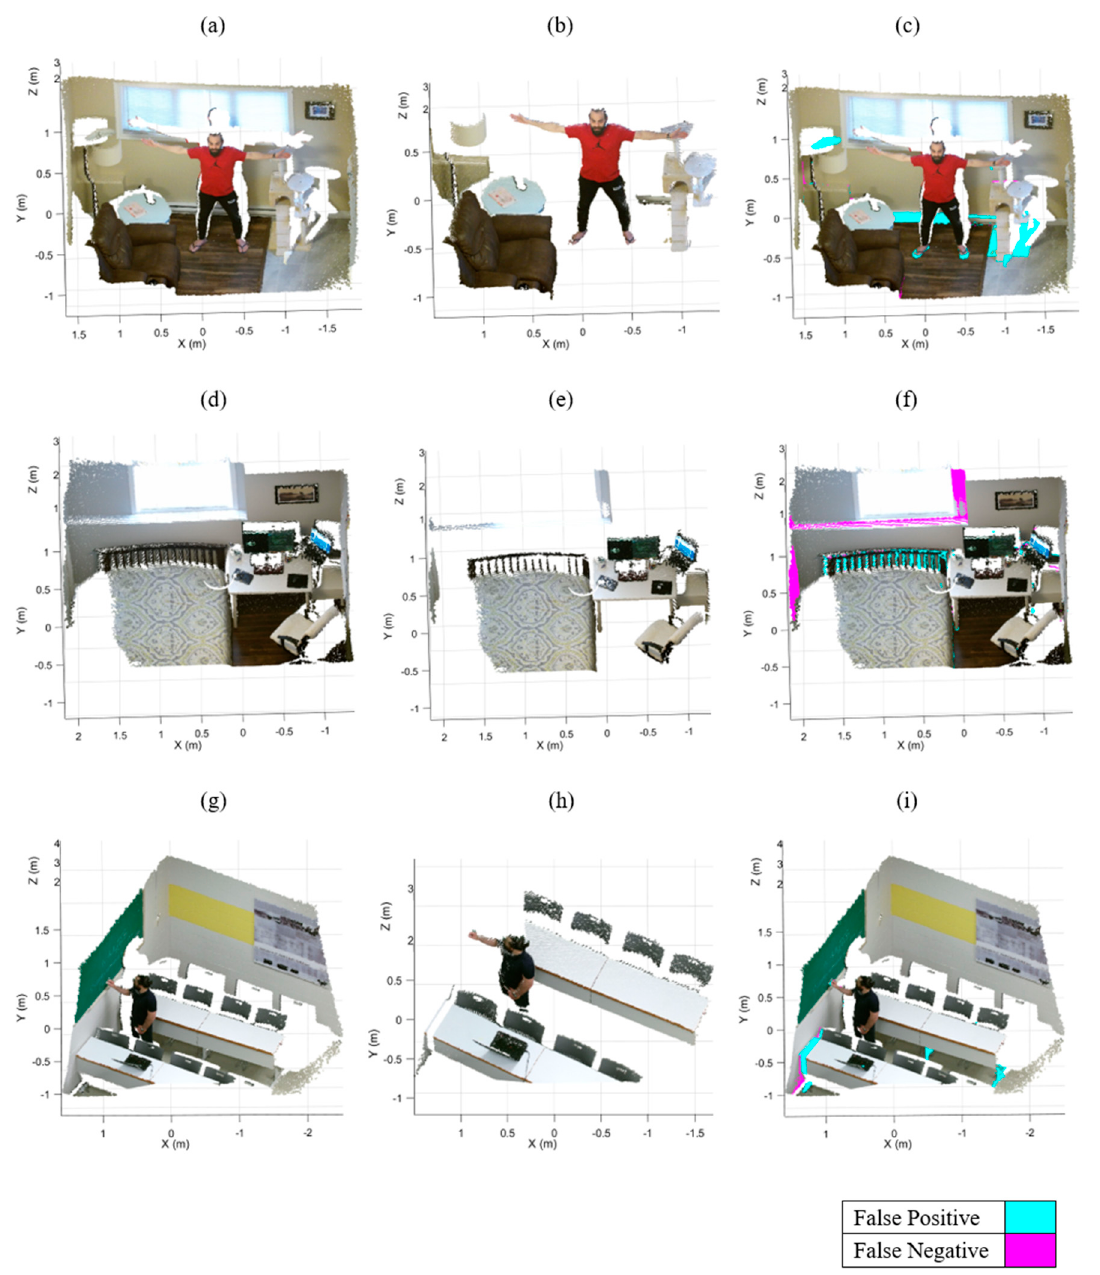
Figure 8. Output results of IR-RANSAC. The original point clouds, Room-1 ( a ), Room-2 ( d ), and Room-3 ( g ), are visualized with all super-surfaces removed ( b ), ( e ), and ( h ) respectively. The false positive (cyan) and false negative (magenta) points are highlighted over the original point clouds for the Room-1 ( c ), Room-2 ( f ) and Room-3 ( i ) datasets. Incorrectly classified points are almost always associated with the points belonging Our IR-RANSAC method eliminated nearly all points belonging to the